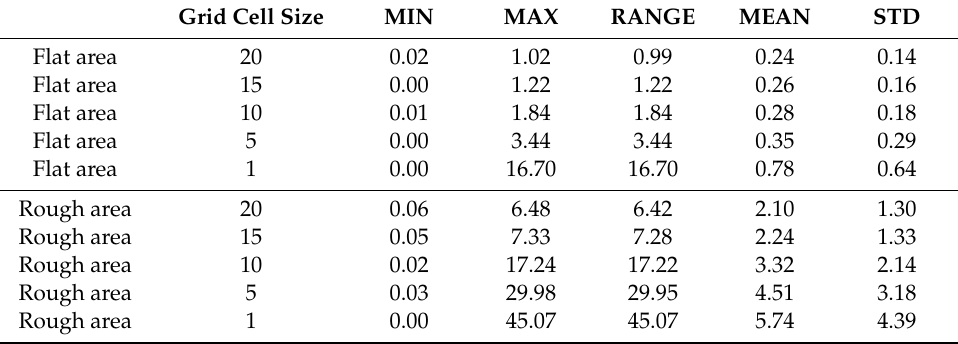
Table 1. Comparison of seafloor slope statistics obtained for di ff erent grid cell sizes (see Figure 10). MIN refers to the minimum slope, MAX refers to the maximum slope, RANGE show the di ff erences between MIN and MAX while MEAN is the average and STD is the standard deviation in each cell. Grid Cell Size MIN